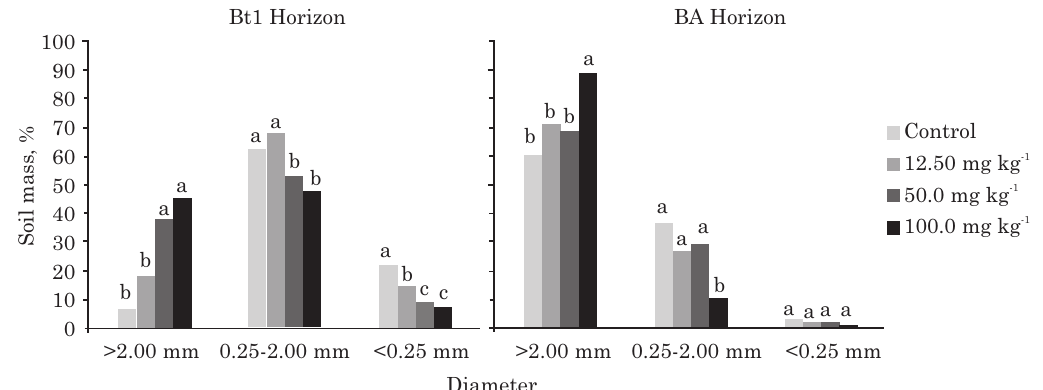
Figure 2. Water-stable aggregates (soil mass in %) of the cohesive horizons Bt1 (Ultisol) and BA (Oxisol) in three diameter ranges (>2.00, 0.25-2.00, <0.25 mm) resulting from the application of aqueous PAM solutions (12.5; 50.0 and 100.0 mg kg -1 ) and a control treatment (distilled H 2 O). Means followed by the same letter in the column do not differ by the Scott-Knott test (p